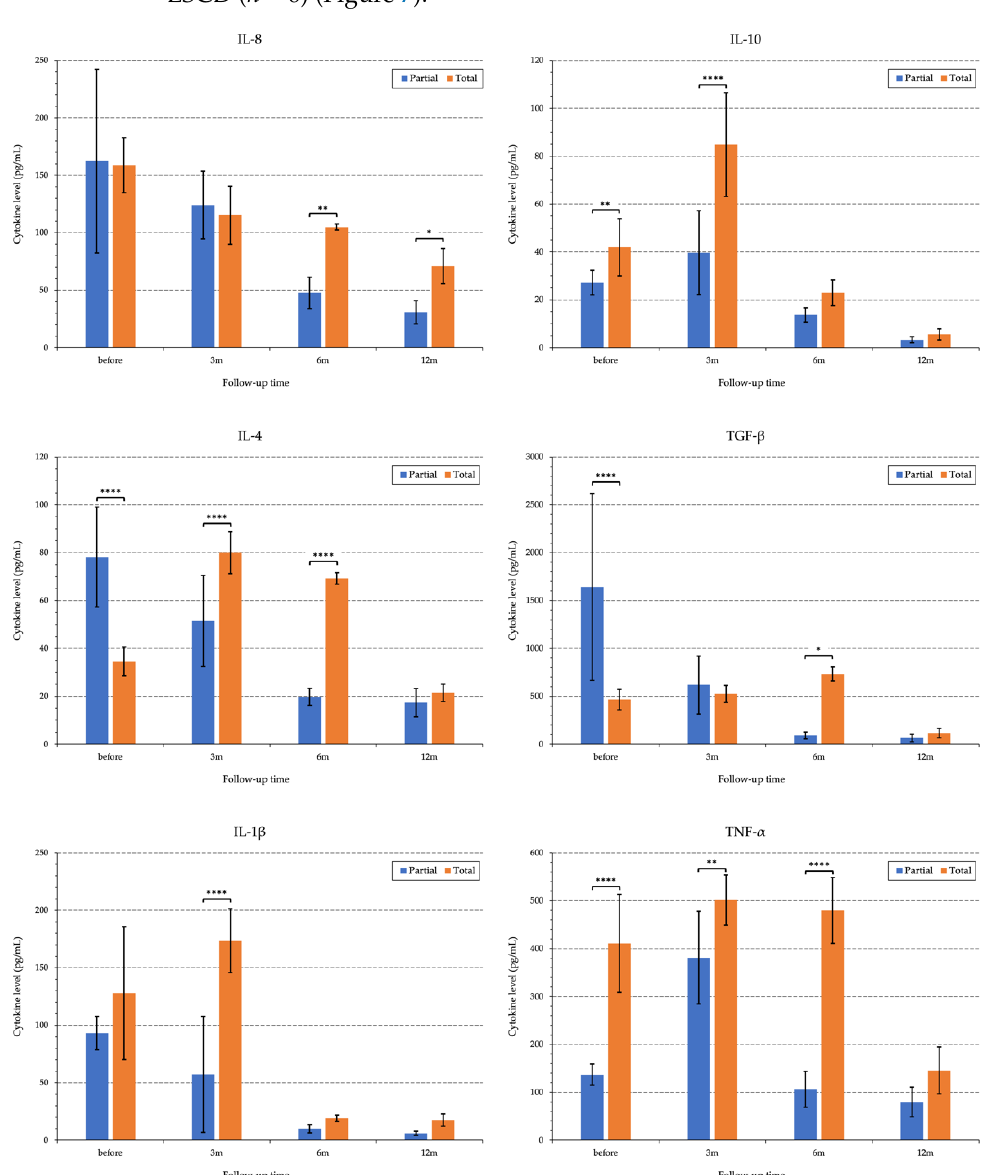
Figure 7. Bar chart of the cytokines levels in tear samples pre-operatively and after GSLET in pa- tients with unilateral LSCD. Columns are presented as mean ± standard deviation. p -values: * — p < 0.05, ** — p < 0.01, **** — p < 0.0001. LSCD — limbal stem cell deficiency, m — month, IL — interleukin, TGF — transforming growth factor, TNF — tumor necrosis factor, m — month, pg/mL — picograms per milliliter.